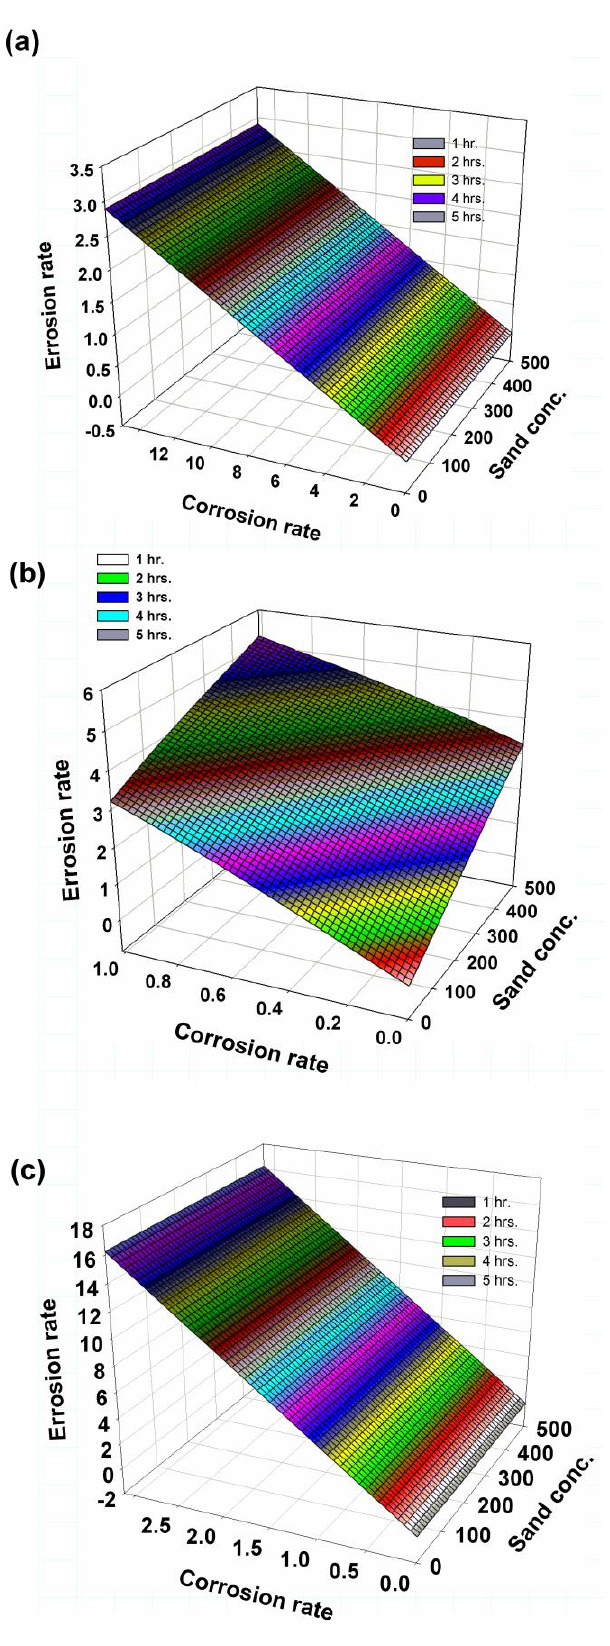
Figure 9. Three-dimensional diagram of sand concentration with erosion and corrosion rates: ( a )